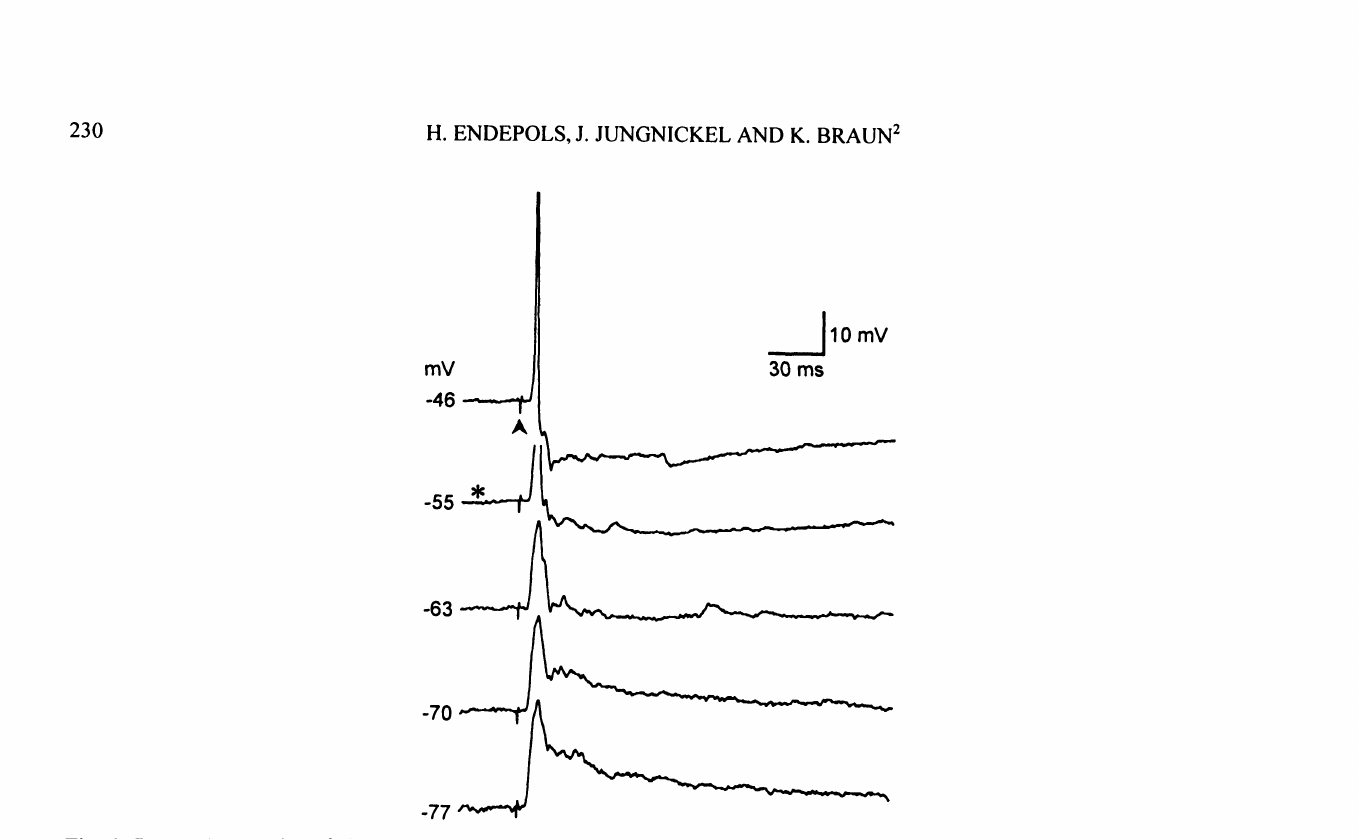
Fig. 6: Reversal potential of the slow IPSP component. Recording traces show the responses of an MNH neuron after single thalamus stimulation at different membrane potentials. The neuron’s resting potential is indicated by an asterisk; the stimulus artifact is indicated by an arrowhead in the upper trace. The slow IPSP that is visible at more depolarized membrane potentials reverses at approx. -65 mV.